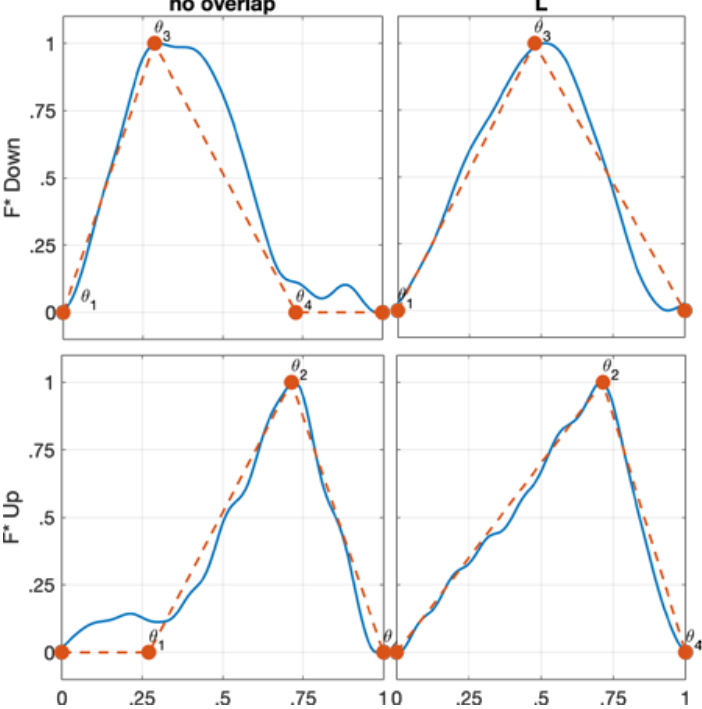
Figure 8. Type I normalized F shapes for tool 2 (tests 7 to 9 in down-milling; tests 10 to 12 in up-milling).